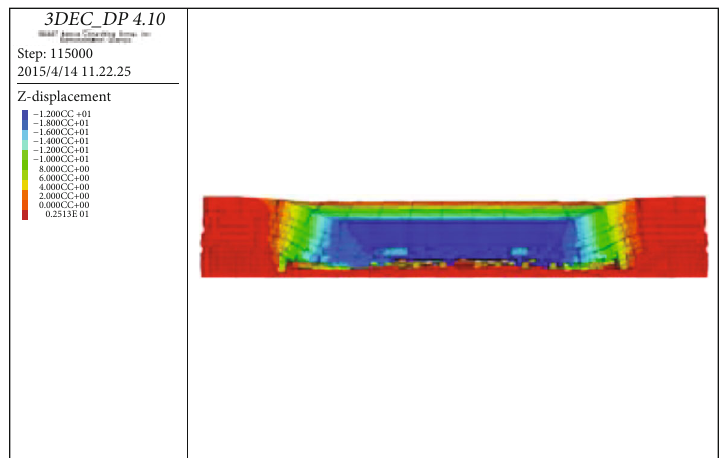
Figure 7: 800m deep surrounding rock vertical displacement diagram.